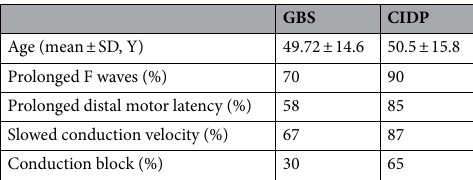
Table 2 demonstrates demographic and clinical data of patients. Expression of HULC was higher in CIDP patients compared with controls (Ratio of mean expression (RME) = 7.62, SE = 0.72, P < 0.001). While expression of this lncRNA was similar between female CIDP